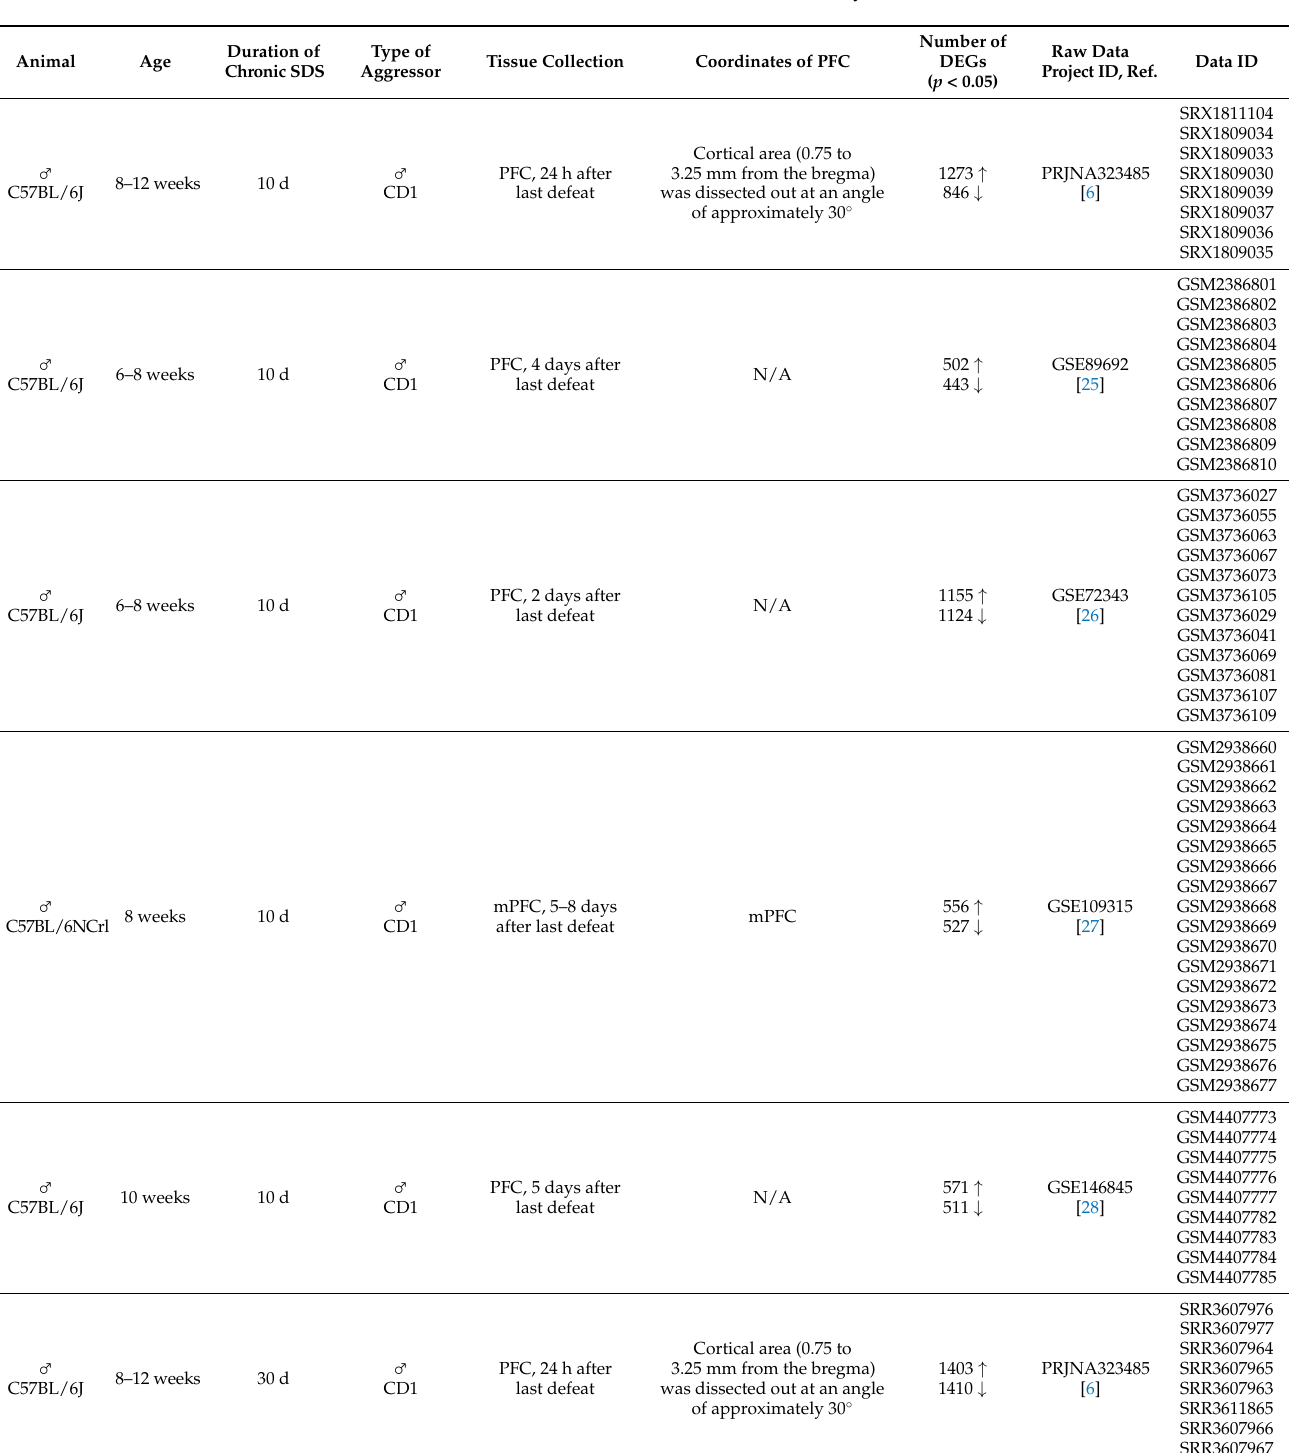
Table 1. The studies on SDS included in the